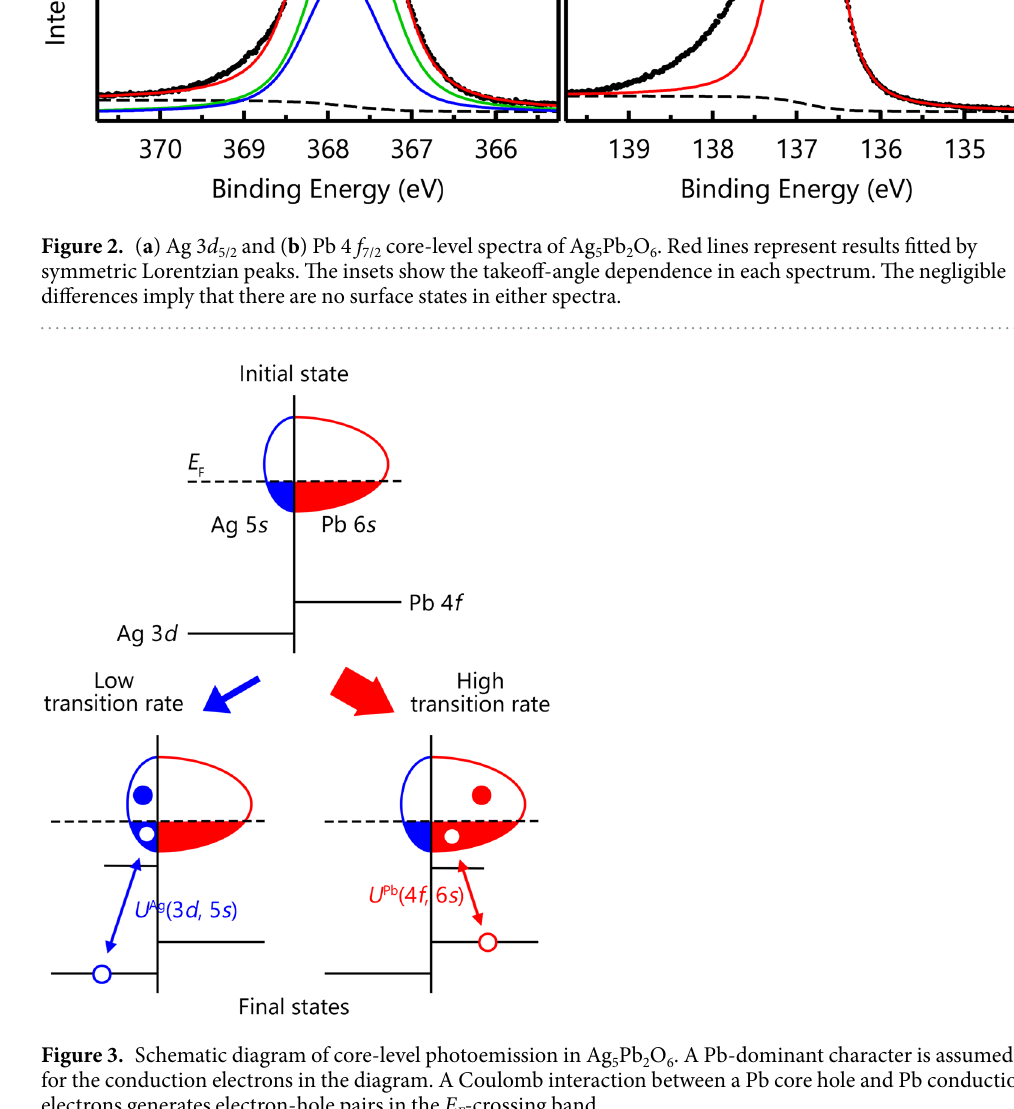
be explained by a single symmetric peak, leaving a large amount of spectral weight at high binding energies as shown in Fig. 2(b). The strong asymmetry of the Pb 4 f 7/2 spectrum should be directly related to dominant Pb 6 s partial DOS near the E F . Figure 3 schematically shows the core-level photoemission processes in Ag 5 Pb 2 O 6 . Local Coulomb inter- action by a core photohole will scatter conduction electrons, thus exciting electron-hole pairs in a E F -crossing band. Due to the local attractive core-hole potential, an impurity-like state appears below the bottom of the valence band. The energies of the final states with electron-hole pair excitations are higher than that of the lowest energy state, resulting in a large spectral weight at a high binding energy and an asymmetric core-level lineshape. In Ag 5 Pb 2 O 6 , we observed that a Ag 3 d 5/2 spectrum is nearly symmetric, indicating few excitations at the Ag 5 s conduction band. In contrast, the Pb 4 f 7/2 core-level spectrum is highly asymmetric, which implies that many